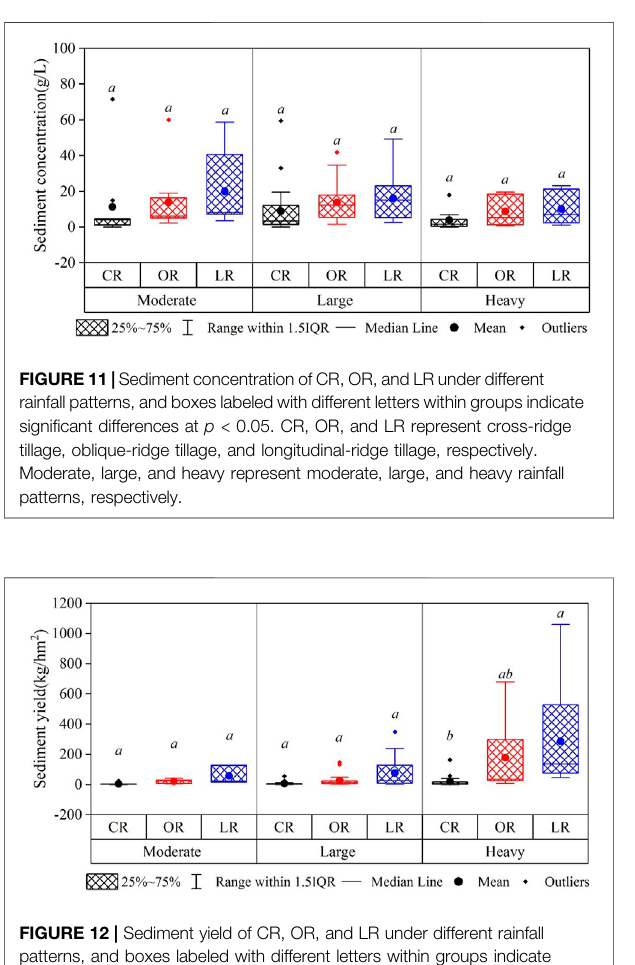
Frontiers in Earth Science |